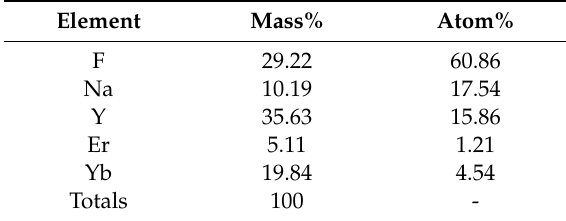
Figure 2. SEM images of ( a ) NaYF 4 :Yb,Er, ( b ) TiO 2 particles, and NaYF 4 :Yb,Er phosphors coated with ( c ) TiO 2 , ( d ) N-TiO 2 , and ( e ) CNS-TiO 2 . Table 1. Elemental analysis for NaYF 4: Yb,Er.